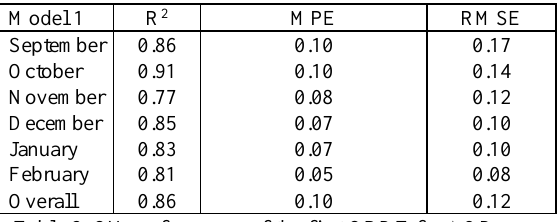
Table 2. CV performance of the first GBDT for AOD gap-